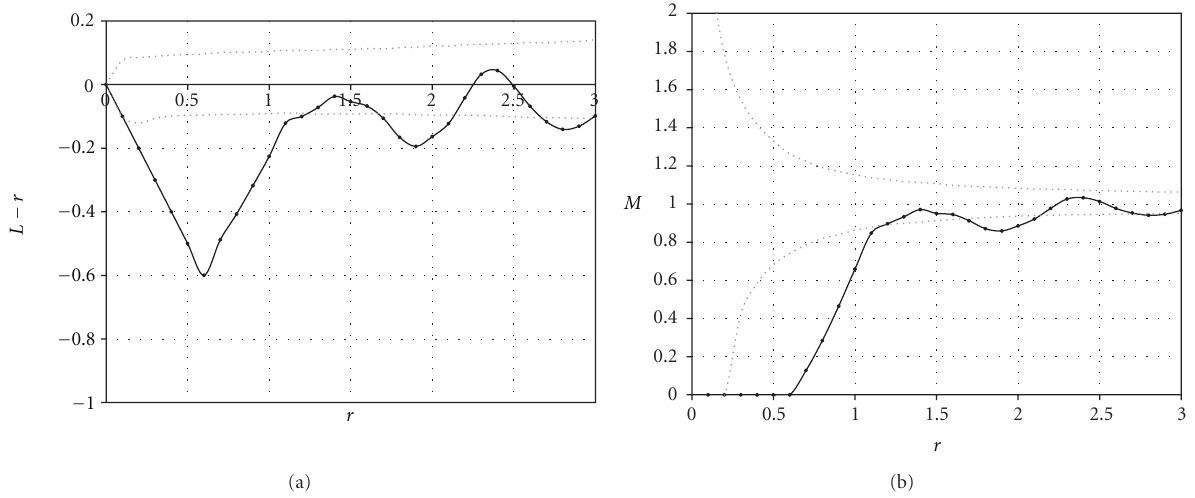
Figure 4: Regular point set, univariate L and M functions for the regular point set. Both functions detect dispersion.